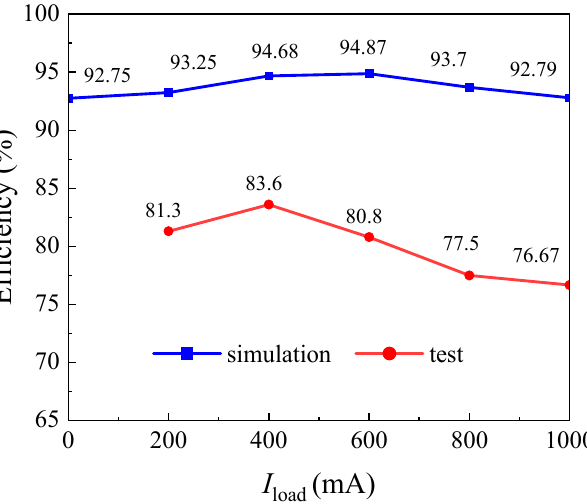
Figure 13. Comparison between the simulated and test results of the buck converter efficiency at different currents ( V IN = 14.5 V, V OUT = 5 V).